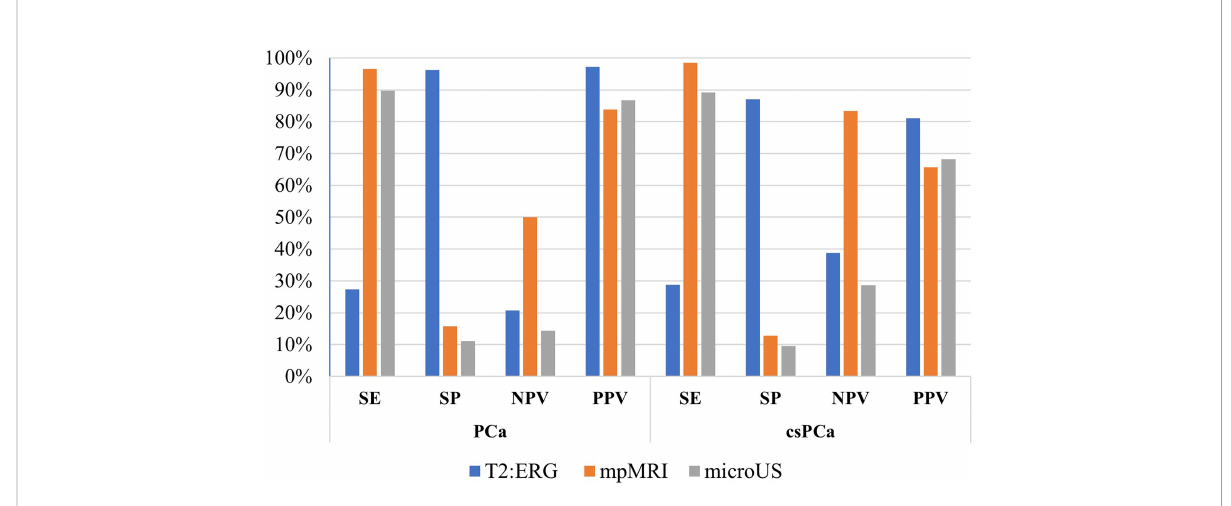
FIGURE 1 Diagnostic performance in comparison between fusion gene T2:ERG, mpMRI, and microUS.